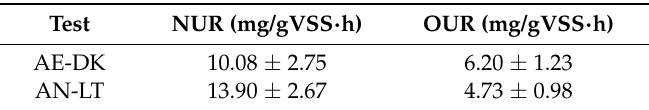
Table 1. NUR and OUR tests results.